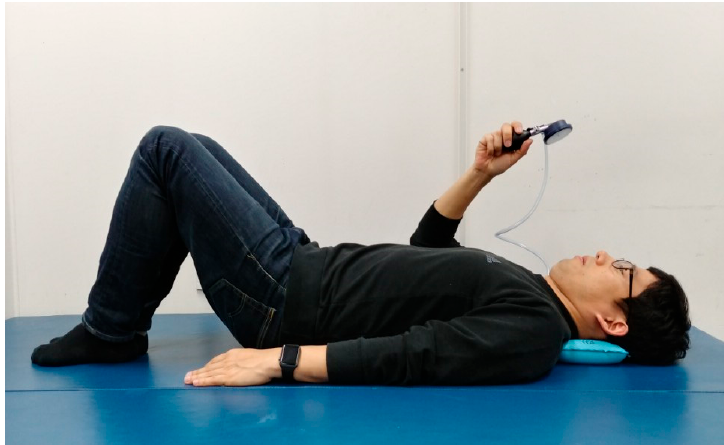
Figure 2. Cervical deep muscle flexion exercise.